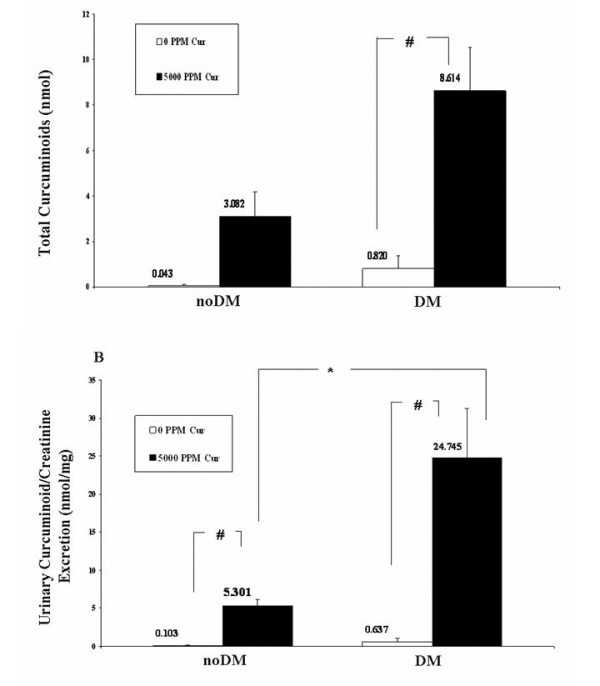
Urinary curcuminoid excretion in noDM and DM mice fed with curcumin versus control chow. Curcumin metabolites were measured by High Performance Liquid Chromatography (HPLC) as a measure of bioavailability in a timed urine collection. (a) Total urinary curcuminoids in nmol and (b) Urinary curcumin/creatinine in nmol/mg. All data are log-transformed (log10). *P < 0.05; #P < 0.01.